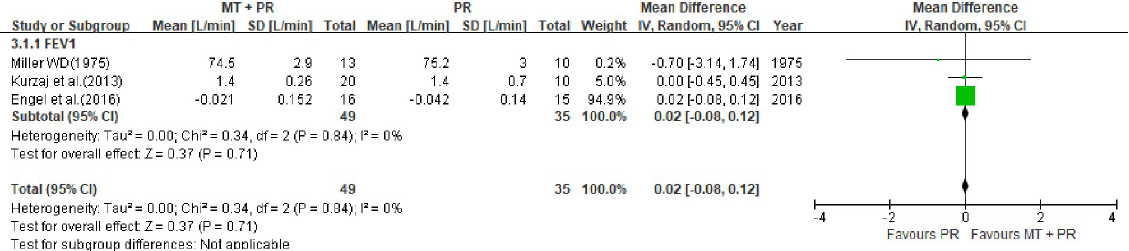
Fig 6. Forest plots for comparison of forced expiratory volume in one second (FEV 1 ) between manual therapy (MT) plus pulmonary rehabilitation (PR) and PR alone.